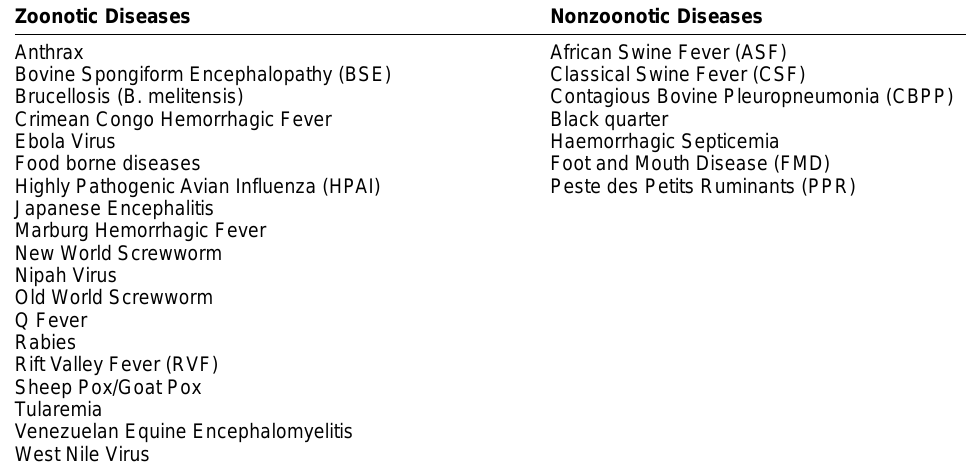
Table-1. GLEWS has given the following list of diseases of common interest [31] Zoonotic